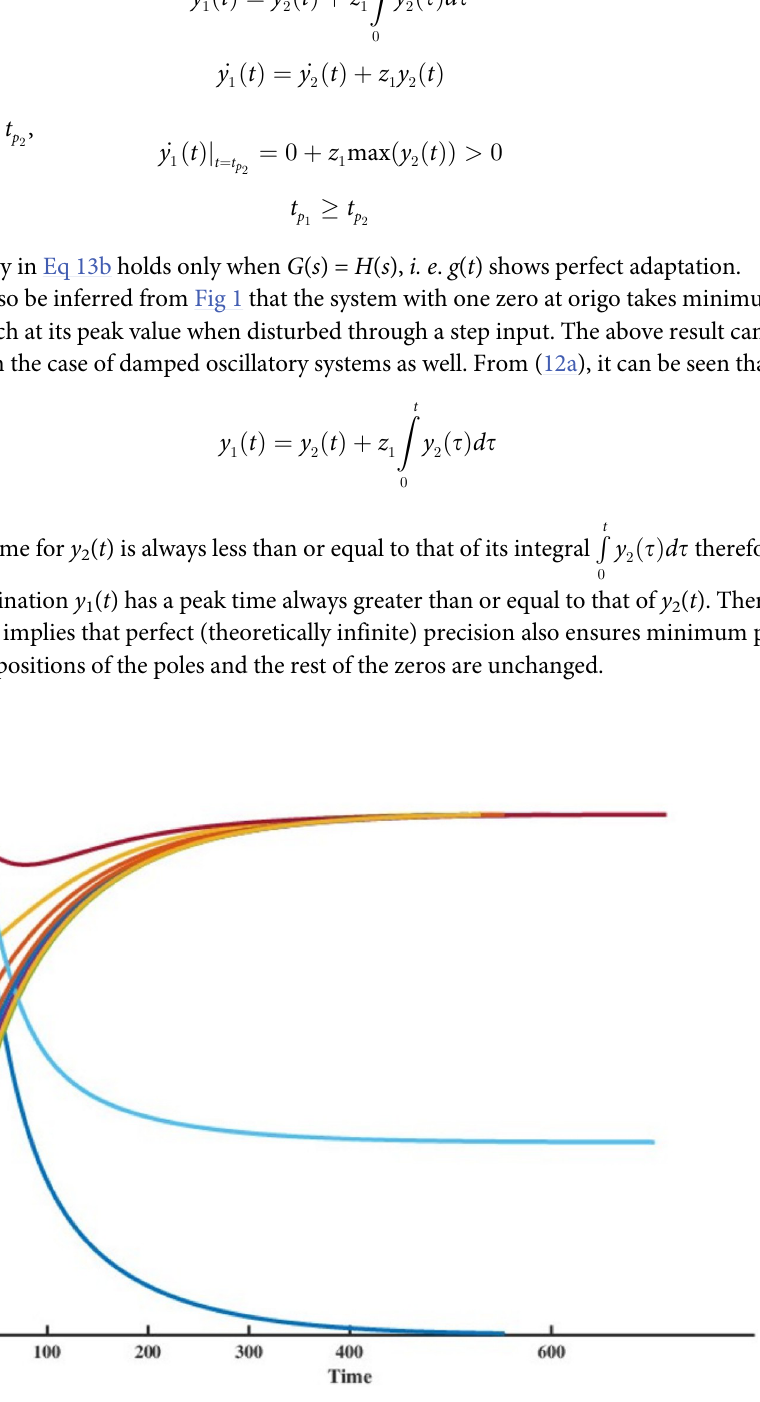
Fig 1. Comparison of peak times associated with the step responses for a set of ten transfer functions in S with five poles and four zeros. It can be seen that the transfer function with zero gain (Response shown in dark blue) provides minimum peak time. The peak values have been kept